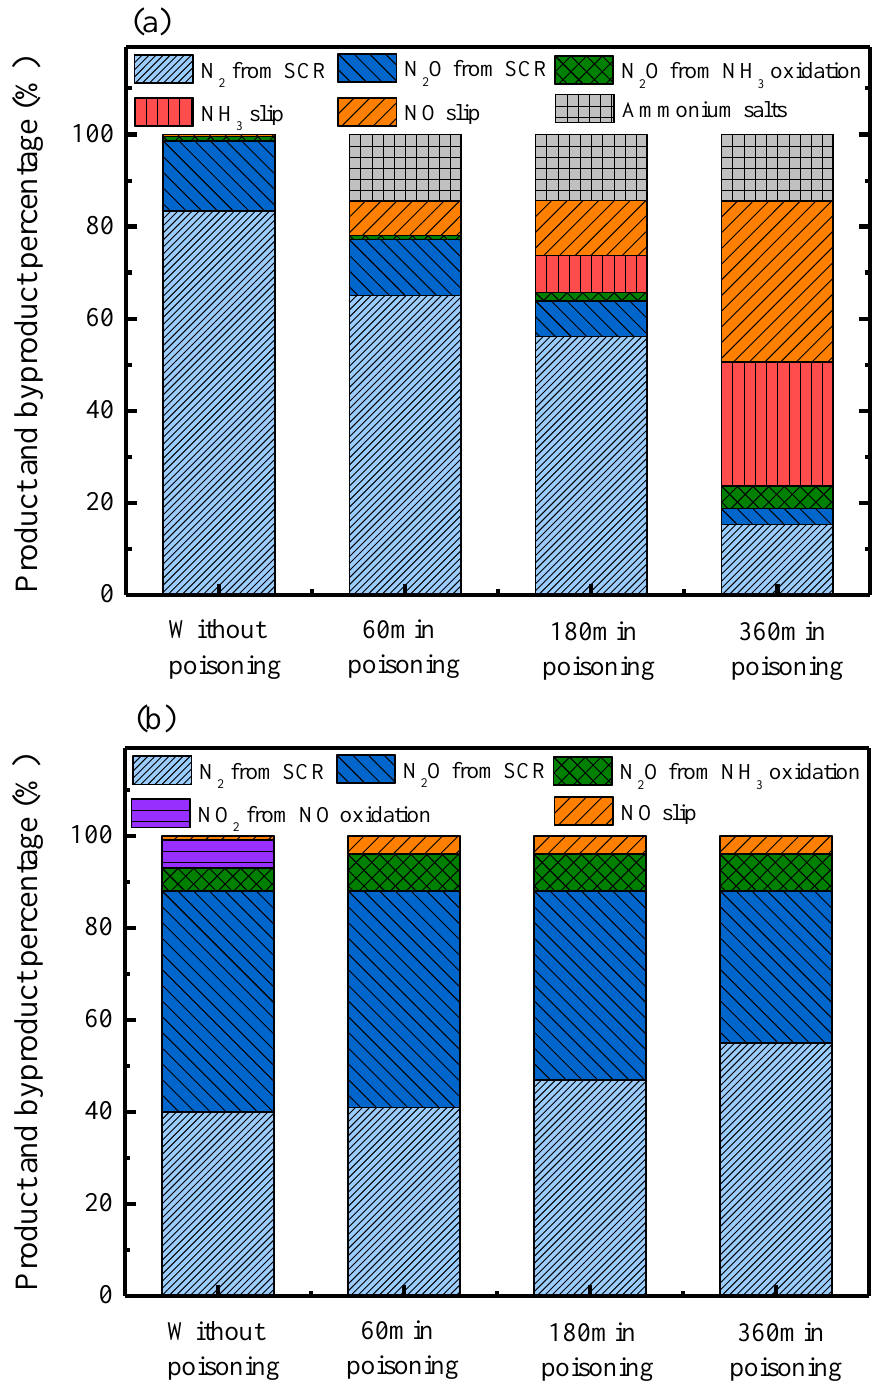
Figure 7. Product and byproduct percentages of N-containing species during the SCR process over MnFe/TiO 2 catalyst with SO 2 poisoning at ( a ) 150 ◦ C and ( b ) 300 ◦ C. The inlet NH 3 and NO molar concentration ratio was 1:1; and the percentage calculation formulas were based on those listed in